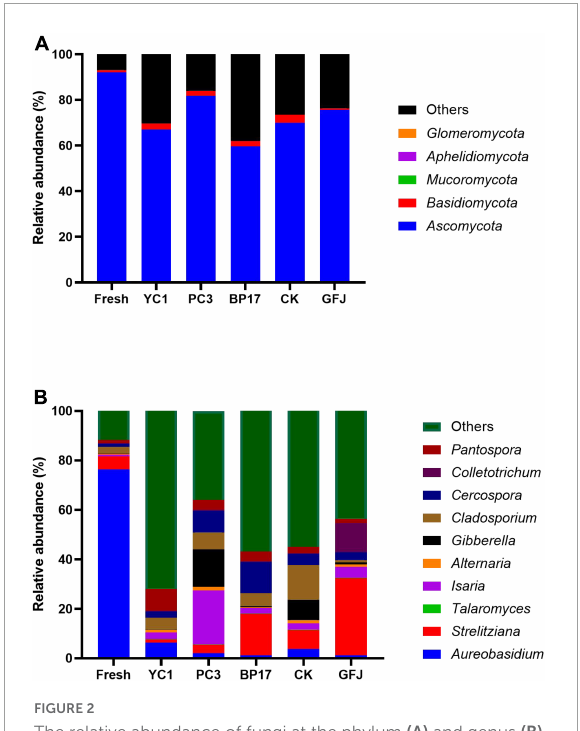
FIGURE2 The relative abundance of fungi at the phylum (A) and genus (B) levels in fresh paper mulberry and silages treated inoculated with saline (CK), with a commercial inoculant (GFJ, a combination of Lactiplantibacillus plantarum and Lentilactobacillus buchneri , 1.0 × 10 6 cfu/g of FM) or with one of the three selected strains (YC1, Lactiplantibacillus plantarum ; PC3, Levilactobacillus brevis ; BP17, Lactiplantibacillus plantarum ) at 1.0 × 10 6 cfu/g of